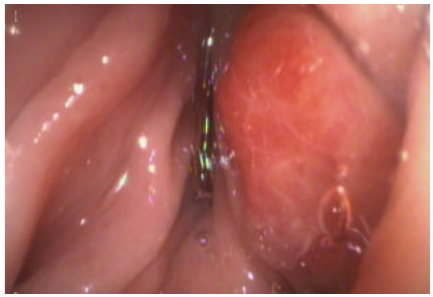
Figure 1: Colonoscopic appearance of lesion.